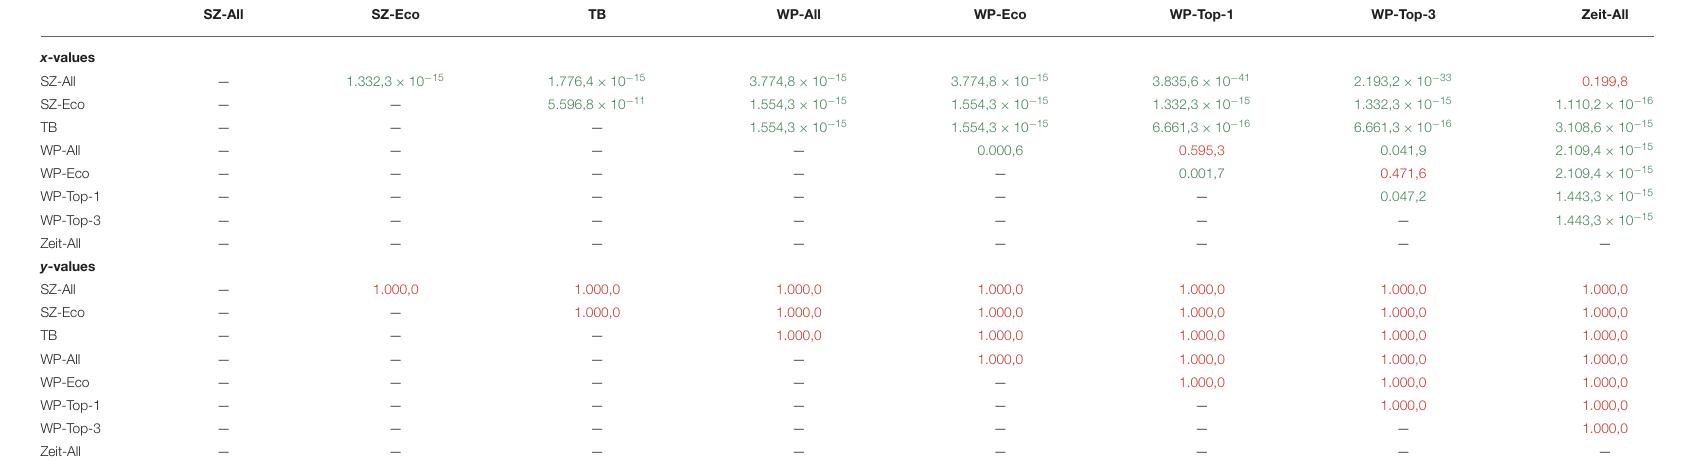
TABLE 8 | P -values of the Kolmogorov-Smirnov goodness-of-fit test applied to the pairwise combinations of the x and y values of the distributions in Figure 10 . SZ-All SZ-Eco TB WP-All WP-Eco WP-Top-1 WP-Top-3 Zeit-All x -values